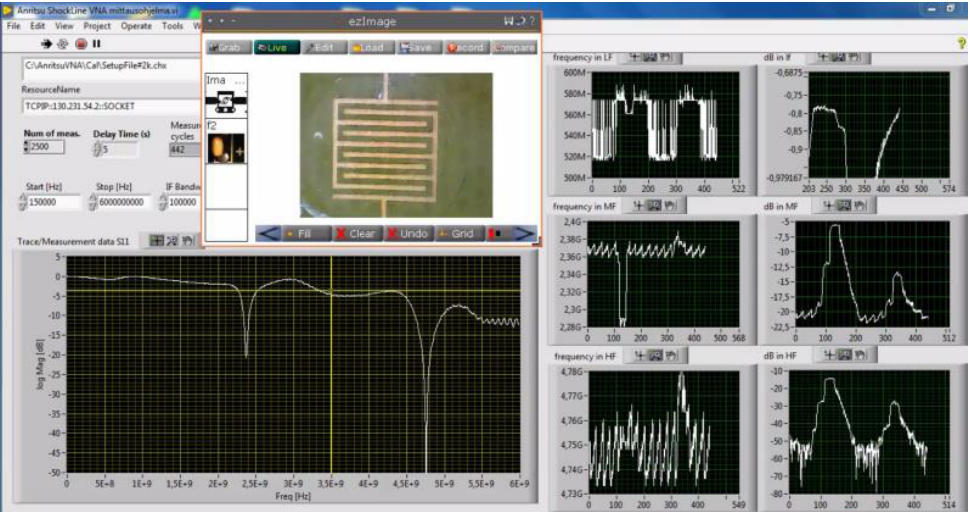
Figure 7. Overview of the LabView user interface. Settings are shown in upper left corner next to the USB real-time microscope image; below is shown the S11 (dB) measurement, and on the right there are three resonance peaks plotted as frequency or attenuation vs. time.